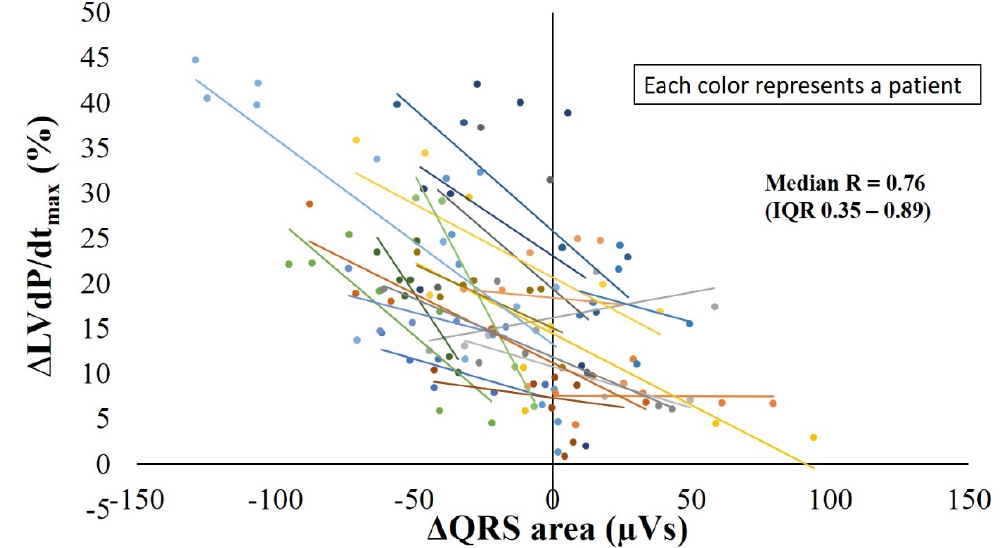
Figure 4. Plots of the relationship between ∆ QRS area and ∆ LVdP/dt max in individual patients from Zanon et al. [16]. Only patients with at least three pacing measurement were plotted ( n = 21). Median R and interquartile range (IQR) are dis- played.